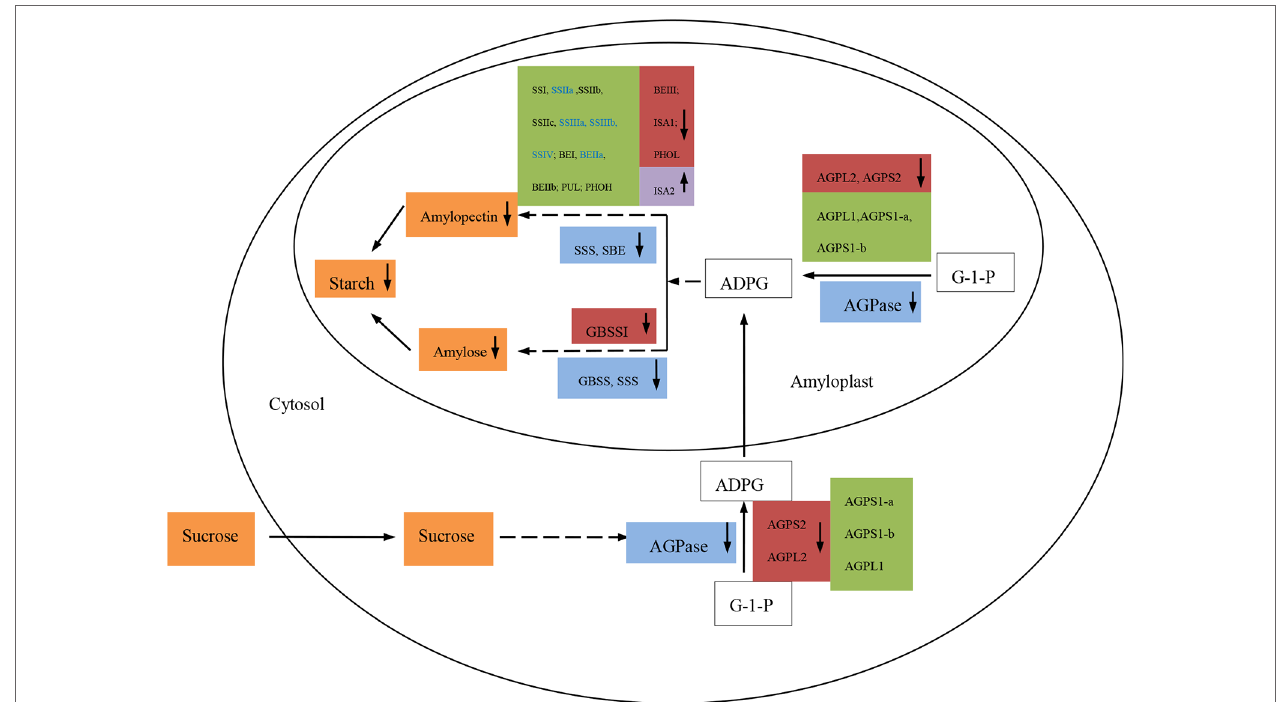
FIGUrE 6 | A simplified model of the starch biosynthesis pathway under conditions of high temperature and drought stress. Red boxes: genes in which the expression levels were down-regulated (down arrow) by high temperature (HT), drought stress (DS), and HT+DS treatments. Purple boxes: the only gene ( ISA2 ) in which the expression level was up-regulated (up arrow) by HT, DS, and HT+DS treatments. Green boxes: genes in which the expression levels were down-regulated (down arrows) by HT but up-regulated (up arrows) by DS. Genes in which the names are shown in blue were down-regulated (down arrows) by the combined HT+DS treatment. Blue boxes: Key enzymes involved in starch biosynthesis in which the activities were reduced (down arrows).Orange boxes: sugars and starches.